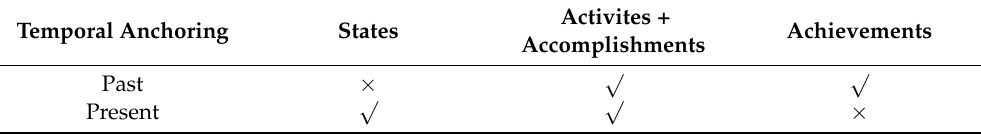
Table 2. Temporal properties of aspectual types of REAL -V-Ø utterances in Bednall (2020, p. 219). Activites + Temporal Anchoring States Achievements Accomplishments √ √ Past × √ √ Present